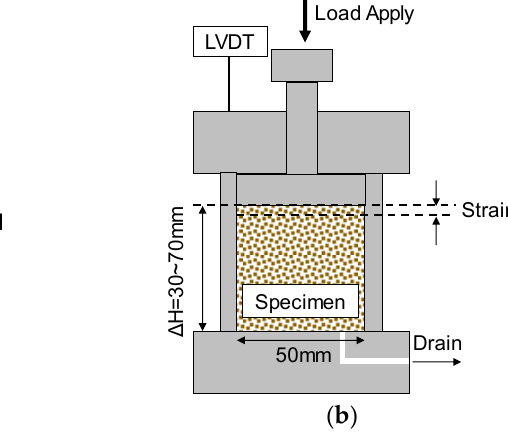
Figure 2. Schematic diagram of lab-scale tests: ( a ) direct shear test; ( b ) consolidation test.